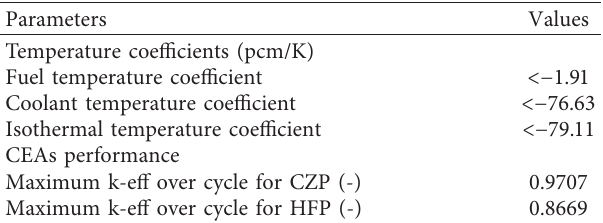
Table 4: Temperature coefficients and CEAs performance of the final core